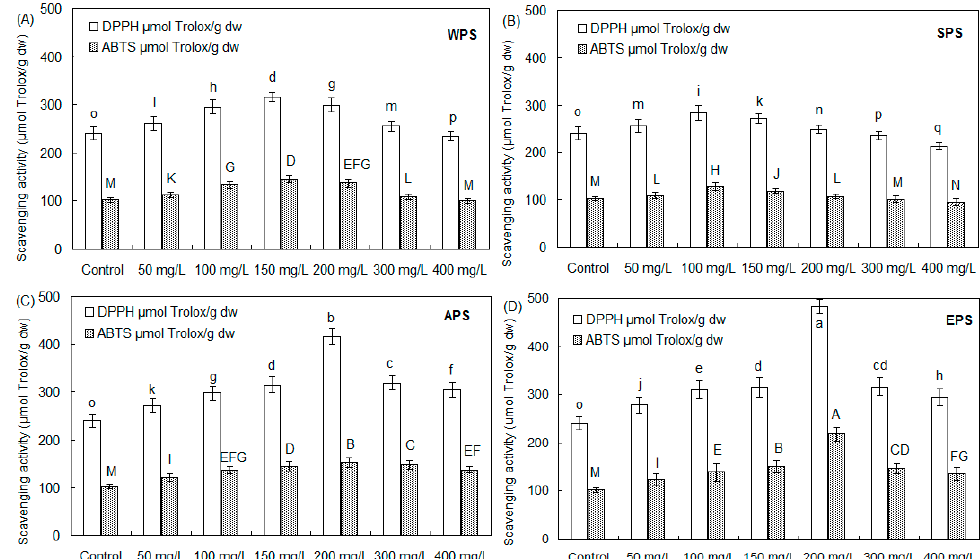
Figure 3. DPPH and ABTS radical scavenging activity of tartary buckwheat sprouts after treatment with WPS ( A ), SPS ( B ), APS ( C )and EPS ( D ) elicitors of endophyte F. oxysporum Fat9 in comparison with the control culture ( n = 3). Different letters (i.e., a–o, A–M) in each column indicated significant differences among the treatment at p = 0.05 level.